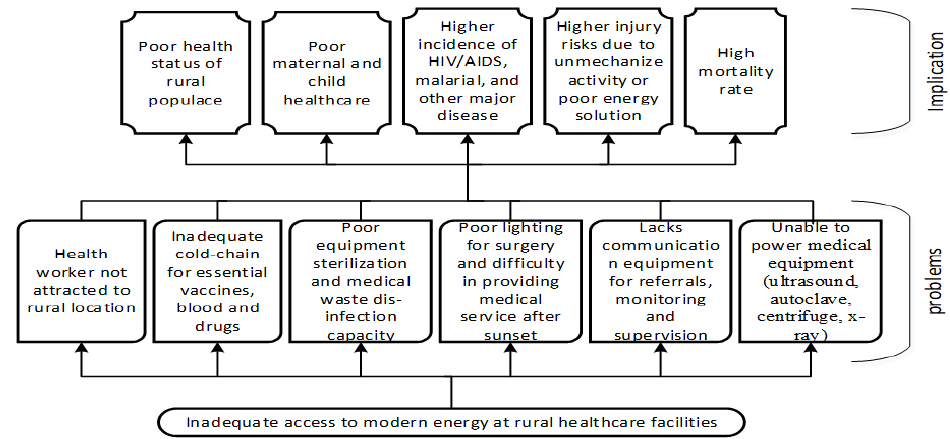
Figure 1. Energy access impacts on rural health care services [24].